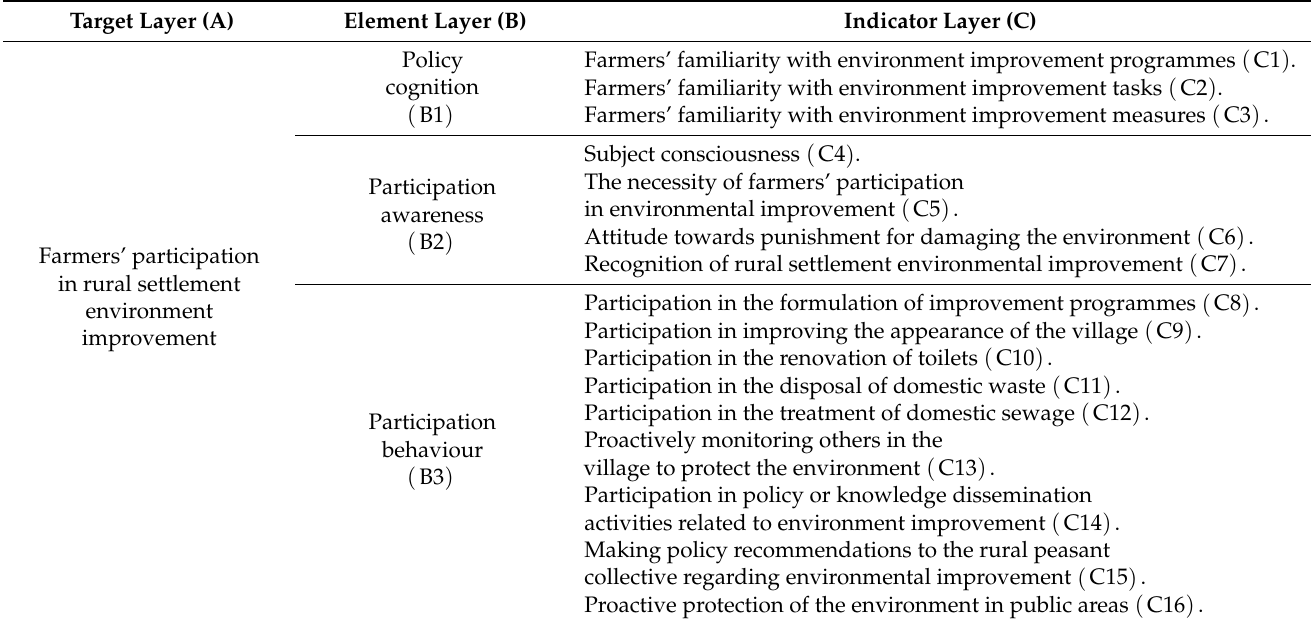
Table 1. Evaluation index system of farmers’ participation in rural settlement environment improvement.